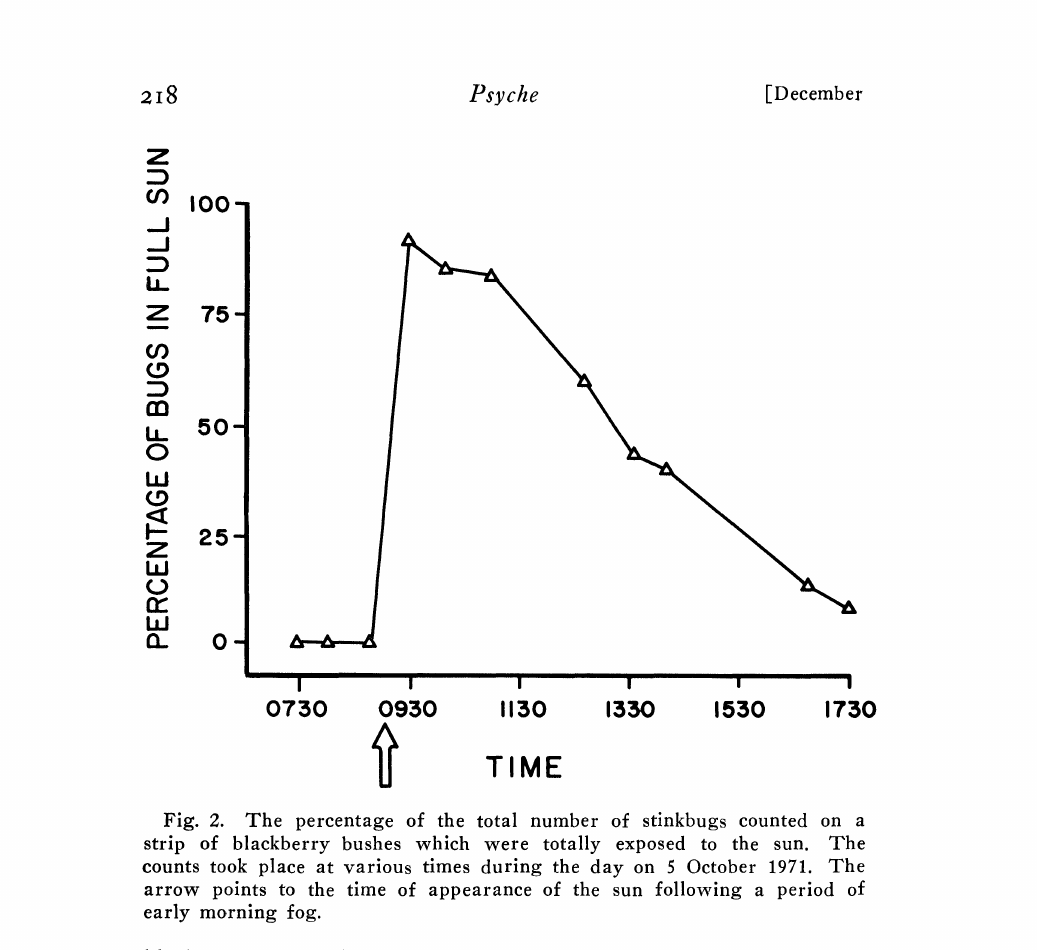
Fig. 2. The percentage of the total number of stinkbugs counted on a strip o blackberry bushes which were totally exposed to the sun. The counts took place at various times during the day on October 1971. The arrow points to the time of appearance of the sun following a period of early morning